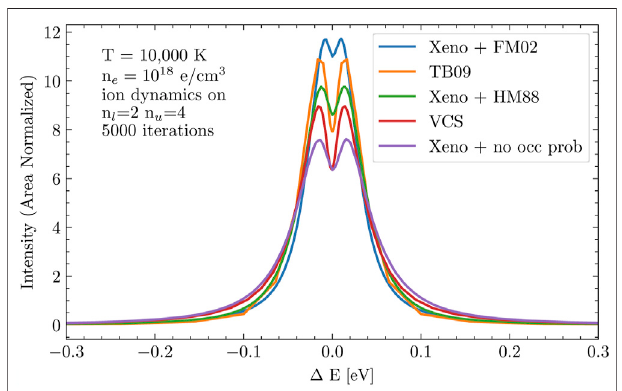
FIGURE 7 | A comparison of different OP treatments for the H β line. Since the FM02 treatment (blue curve) excludes the largest electric fi elds, it results in the narrowest pro fi le. Conversely, including all electric fi eld values ( “ no occ prob ” , purple curve) results in the broadest pro fi le. The red “ VCS ” curve shows the calculations of Vidal et al. (1973) which do not include either ion dynamics or OP, which is why it is narrower than the “ no occ prob ” curve. Taken from Cho et al.